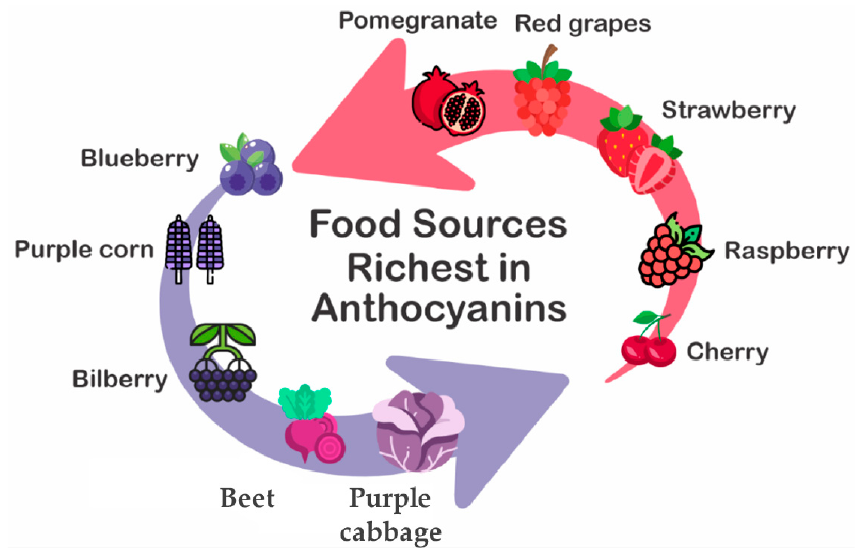
Figure 1. Main sources of anthocyanin dyes. Anthocyanins are natural water-soluble dyes with the most diverse colors and hues: red, blue, and violet. Under acidic conditions, they show red colors due to the presence of the flavylium ion and change to violet and blue as the pH of the medium increases. These dyes have a complex chemical balance, and colored shapes are susceptible to fad- ing by adding water and auto-oxidation reactions [15].